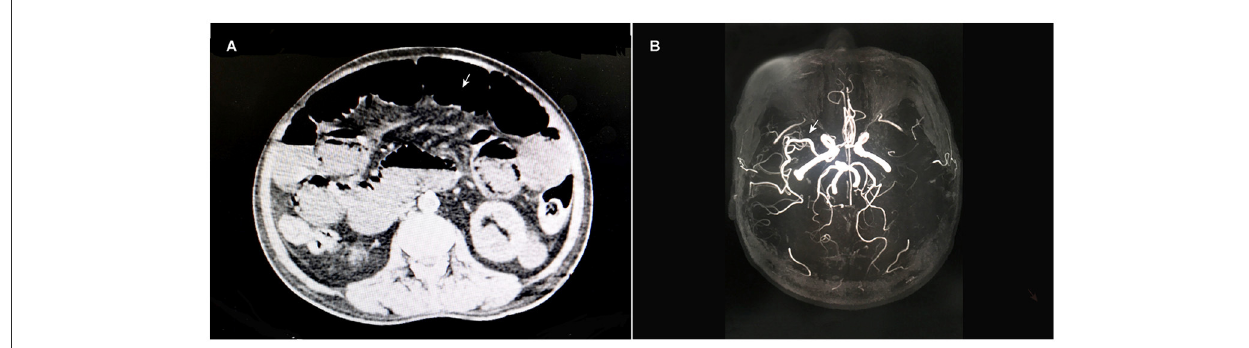
FIGURE1 Abdominal CT scans (A) showed rectal cancer and an intestinal obstruction. The cerebral MRA image (B) showed that the left middle cerebral artery was invisible, while the right was normal.